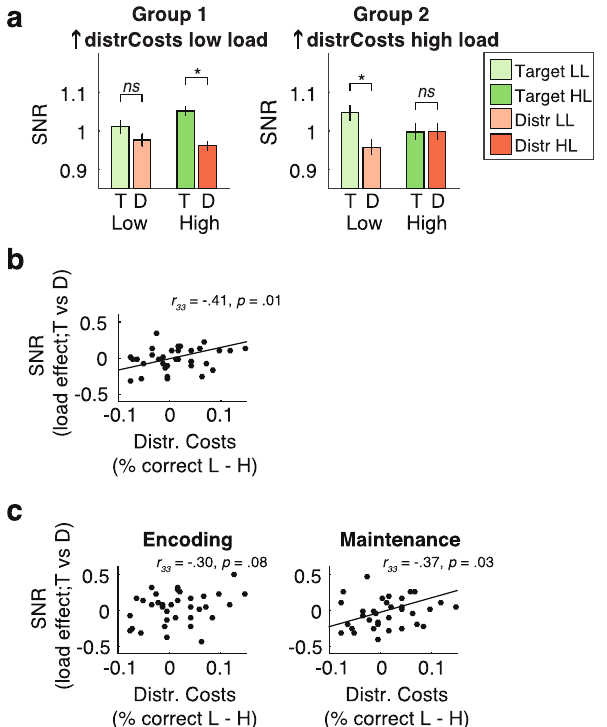
Figure 5. Individual differences in attentional modulation of the second harmonic SSVEP relate to VSTM performance. ( a ) Graphical display of the three-way interaction between the effect of location (T vs. D), condition (low vs. high), and behavioral distractor costs, by means of a median split of participants based on distractor costs. Group 1 consists of participants with low distractor costs (group-average distractor costs were negative in this subgroup), who performed better in the high compared to the low distractor load condition. Participants in group 2 showed high (positive) distractor costs, and thus performed better in the low compared to high distractor load condition. Within each subgroup, differential allocation of attention across target and distractor locations was apparent in the condition in which participants performed best, but was not observable in the condition in which they failed to prevent distractors from interfering with VTSM performance. A post-hoc significant negative correlation between behavioral distractor costs and the difference in attentional allocation to target vs. distractor locations in the high vs. low distractor load condition (double subtraction) confirmed the interaction observed in the ANOVA, ( b ) averaged across VSTM encoding and maintenance, and ( c ) separately for the encoding and maintenance interval. Individuals who paid more attention to target vs. distractor locations under high distractor loads generally displayed reduced VTSM impairments in the high compared to the low distractor load condition. Error bars represent the standard error of the